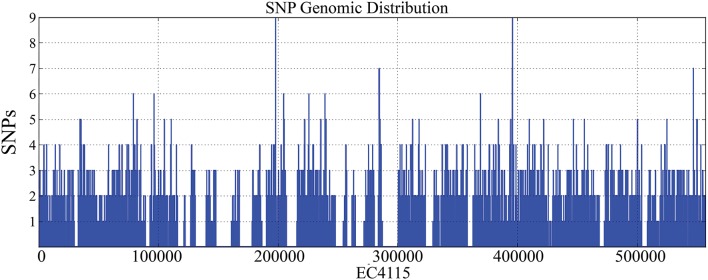
Genome-wide distribution of SNPs. Chromosomal positions of the 3313 identified SNPs were plotted along the EC4115 chromosome using a 1000 bp sliding window. We found SNPs dispersed throughout the chromosome providing no indication for mutational hotspots. Deserted regions lacking SNP calls correspond to excluded mobile regions, such as stx-prophages.